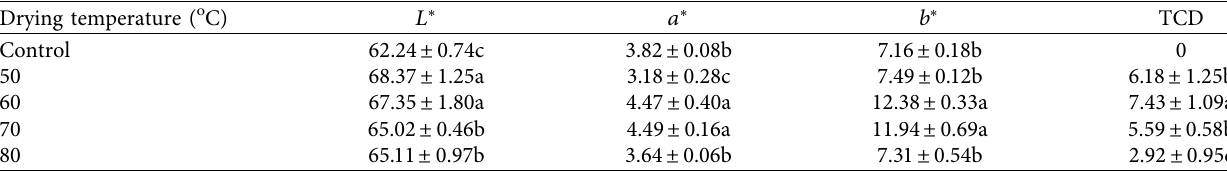
Table 5: Efect of drying temperature on